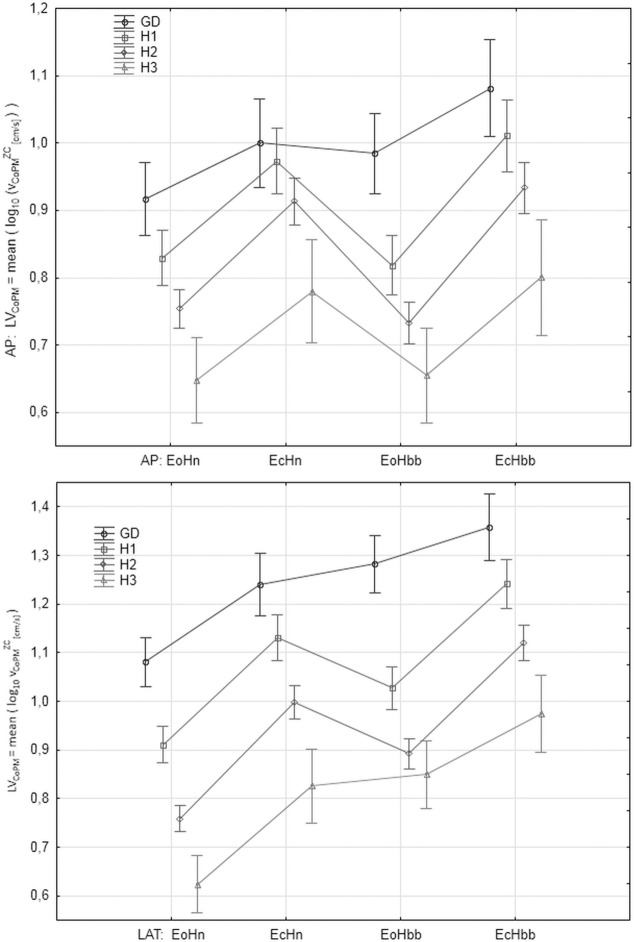
The mean values of LVCoPM = mean(log10(vCoPMZC)) in the subsequent patients and registration condition groups.vCoPMZC represents the velocity of xCoPM signal in the given Zero-Crossing point. Upper: antero-posterior, bottom: lateral component of the signal. Markers denote the standard error of the mean.